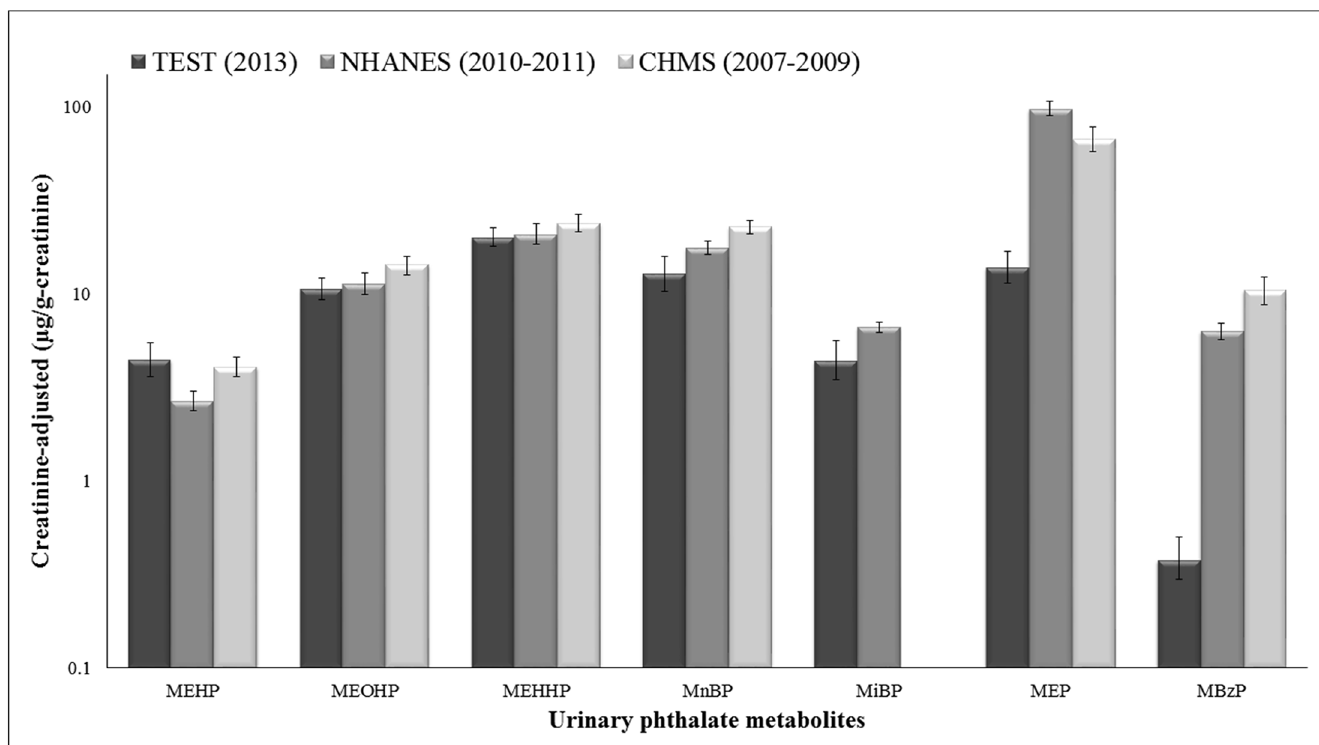
Fig 4. Comparison of urinary levels of seven phthalate metabolites in a general population sample of Taiwanese ( ≧ 7 years), Americans ( > 6 years) and Canadians (18 – 49 years).